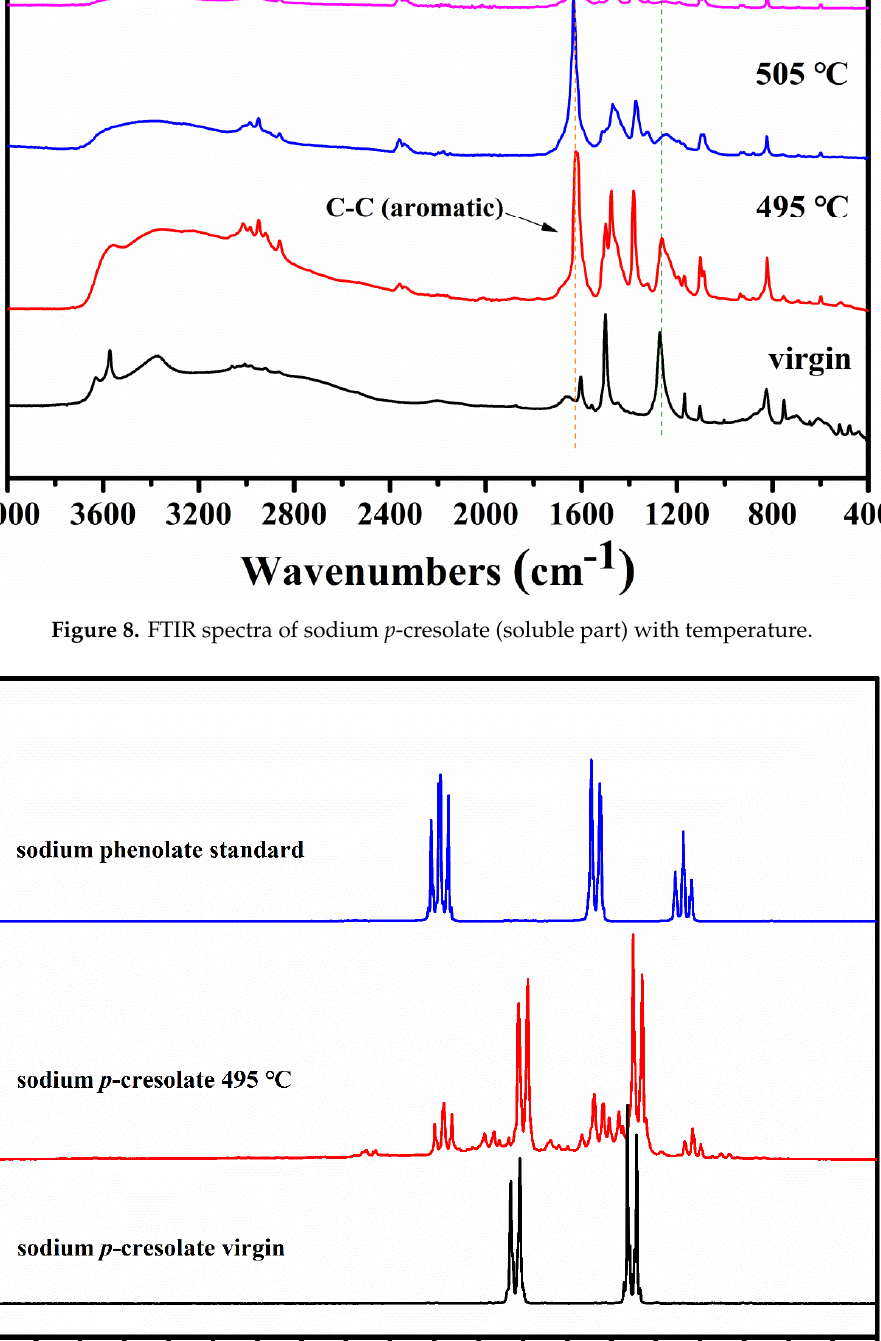
Figure 9. 1 H NMR spectra of sodium p -cresolate collected at 495 °C.